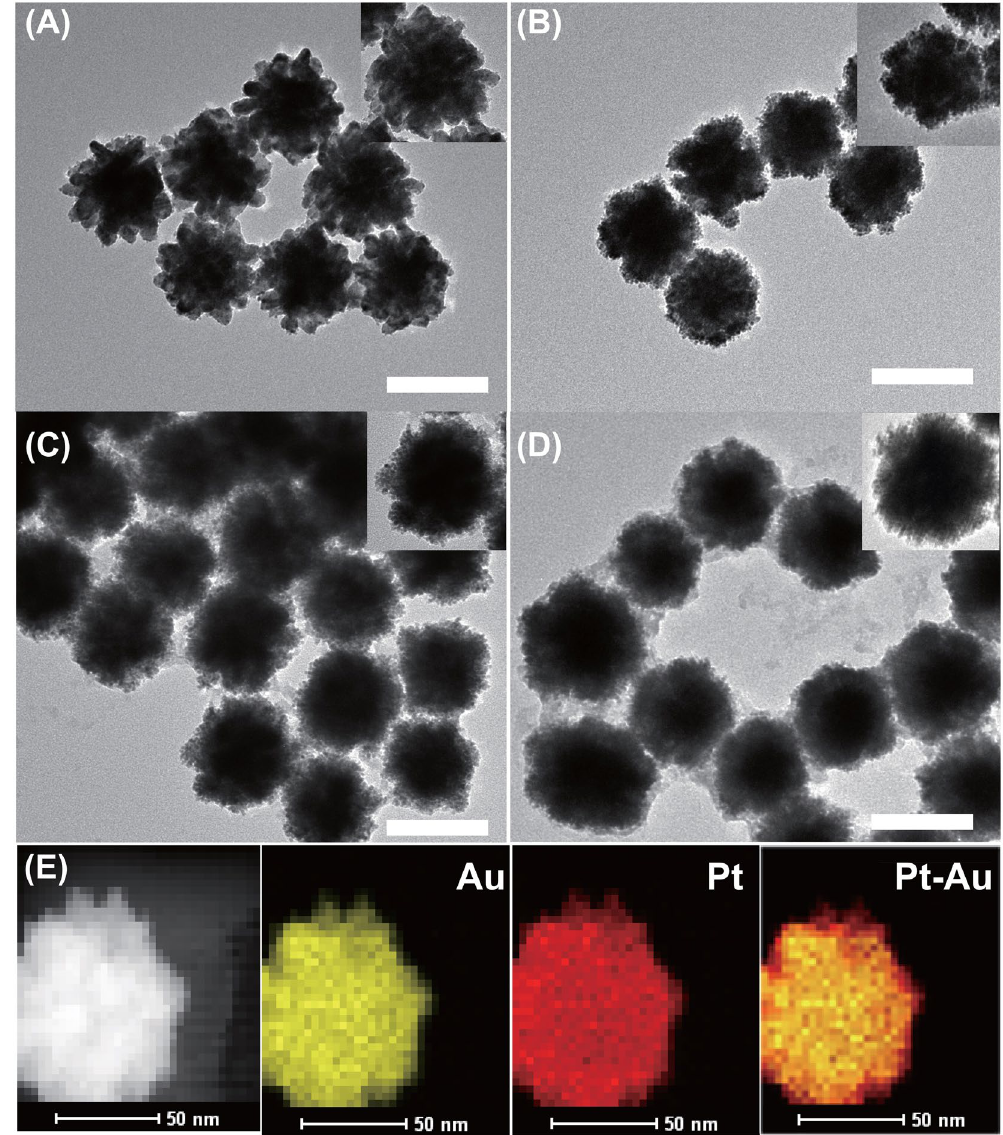
Figure 2. TEM images of different Pt source amount-modulated spiny Au NPs. The insets are the single- nanoparticle views of the four types of Au@Pt NPs. ( A ) Au 99 @Pt 1 NPs ( B ) Au 95 @Pt 5 NPs ( C ) Au 90 @Pt 10 NPs ( D ) Au 85 @Pt 15 NPs. Scale bar: 100 nm. ( E ) HAADF-STEM image and elemental mappings of Au 90 @Pt 10